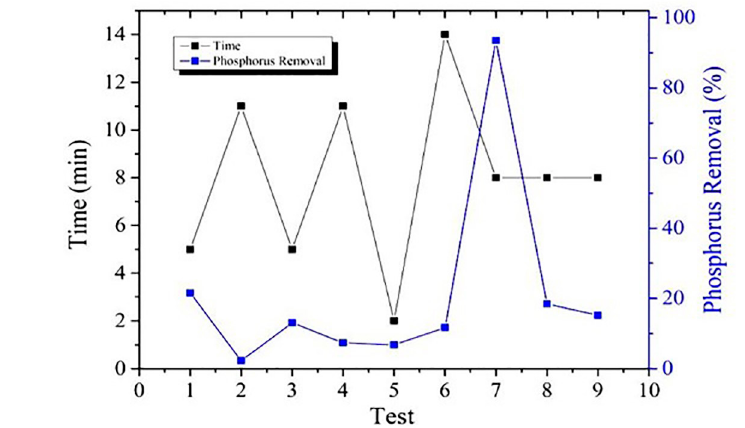
Figure 11. Profile of the percentage of decrease of phosphorus content as a function of contact time with microwave energy.